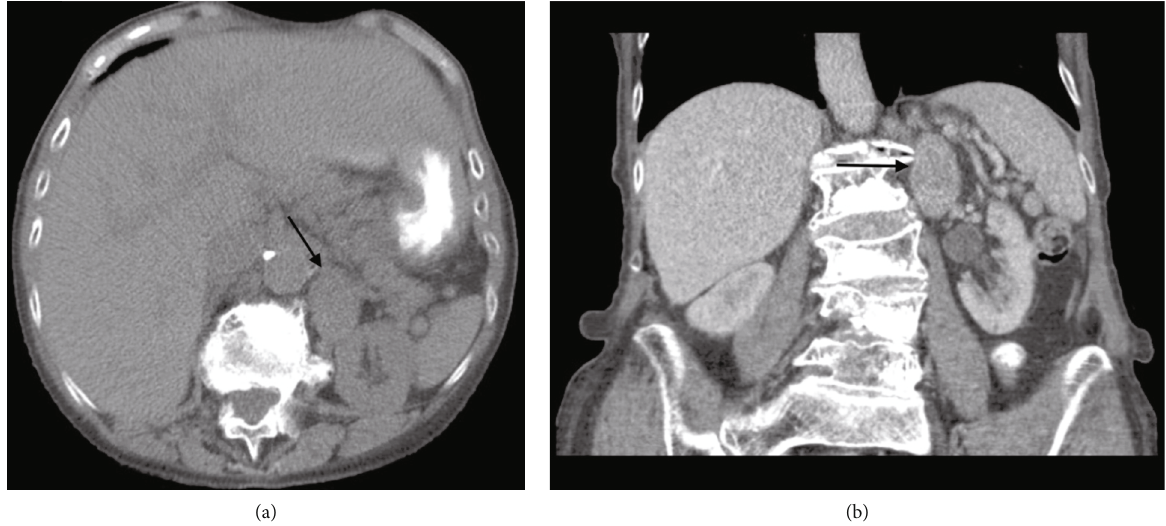
Figure 1: Initial CT abdomen showed a 3.3 cm left adrenal indeterminate